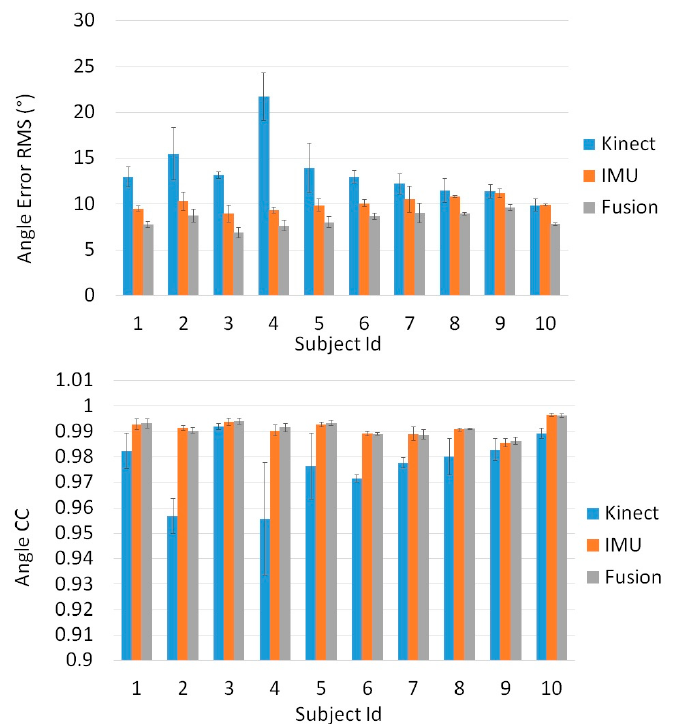
Figure 8. Angle error RMS (°) and angle Correlation Coefficient calculated for the Kinect, IMU and the proposed fusion algorithm Vs the universal goniometer, when IMU sensors are placed directly on the muscle.